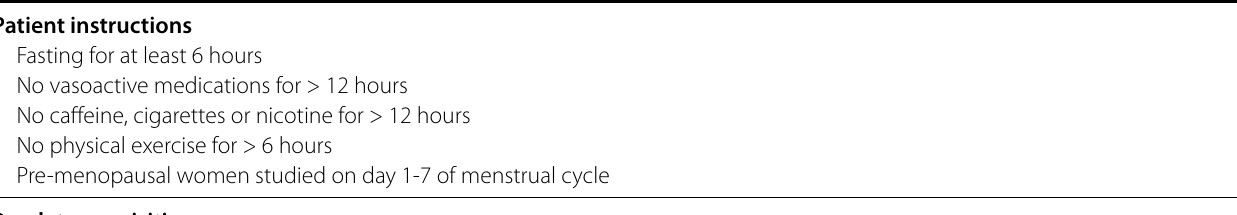
Table 1. Recommendations for brachial artery flow-mediated dilation